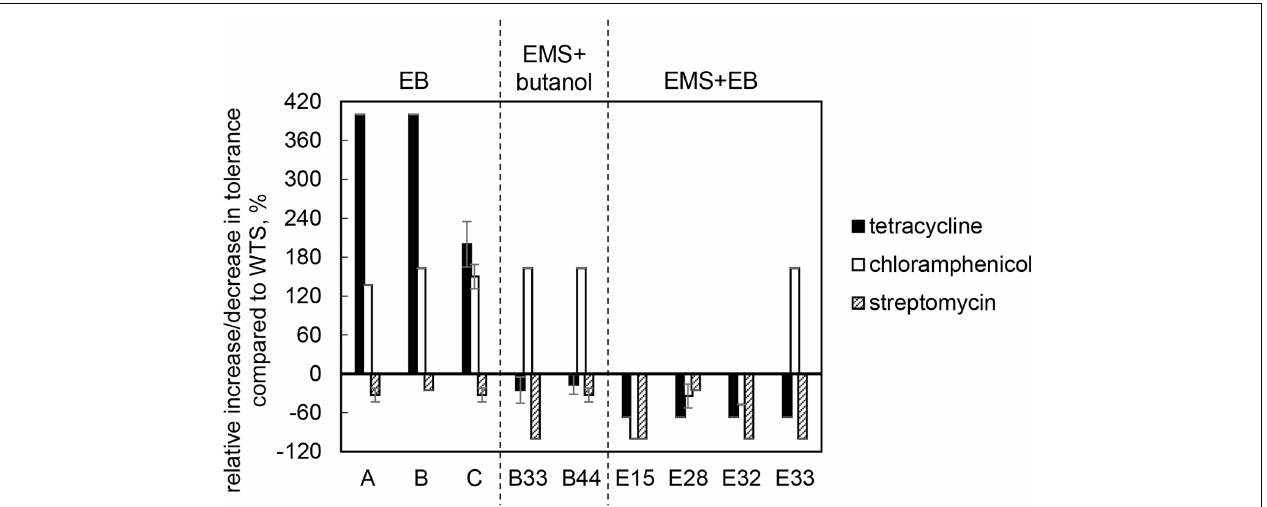
FIGURE 4 | Relative increase/decrease in tolerance to antibiotics tetracycline, chloramphenicol and streptomycin in mutant strains compared to C. beijerinckii NRRL B-598 (WTS). Tolerance levels are expressed as the maximum concentration of substances in TYA medium at which growth of the strains was still detectable. Tolerance of WTS was 3.0 ± 0.0, 19.0 ± 1.4, and 20.0 ± 0.0 µ g/ml of tetracycline, chloramphenicol and streptomycin, respectively. EB – strains obtained by random chemical mutagenesis using EB as a mutagenic agent, when strains were selected directly on agar plates containing EB; EMS + butanol – strains obtained